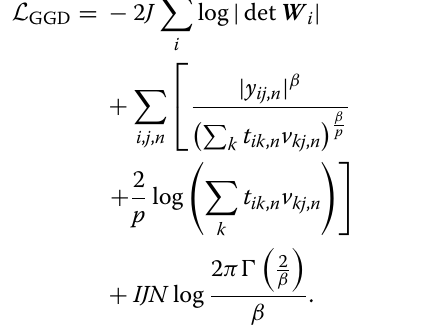
Sampling frequency 16 kHz Window function in STFT Hamming window Window length in STFT 4096 points (256 ms) Shift length in STFT 2048 points (128 ms) Four for music case and two for speech